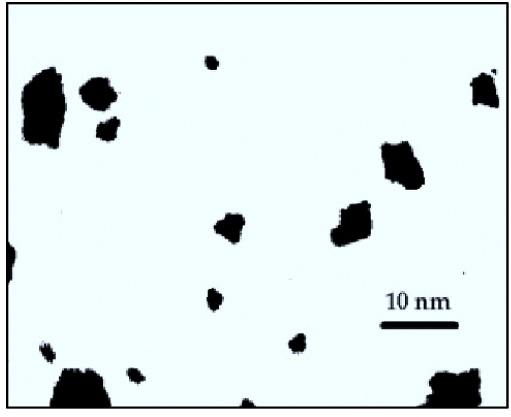
Figure 6. The TEM image of the nanoparticles of the NiO. Table 4. The surface properties of γ -A1 2 O 3 and nano-NiO/ γ -A1 2 O 3